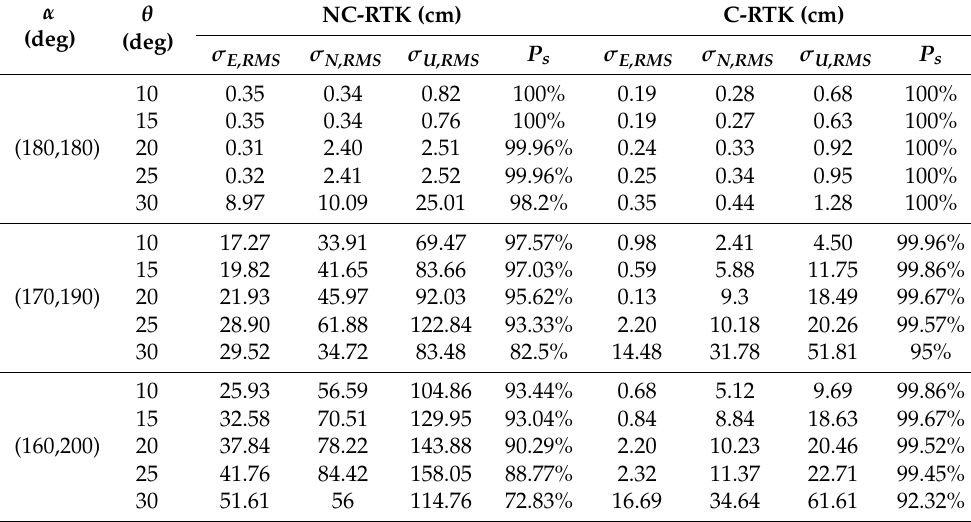
Figure 9. Positioning results with different cutoff elevation angles, in which r 1 and r 2 can track satellites whose azimuth masks are 200 ◦ and 160 ◦ . The column panels from left to right represent different cutoff elevation angles (10 ◦ , 15 ◦ , 20 ◦ , 25 ◦ , 30 ◦ ), respectively. The row panels from top to bottom are tracked satellite numbers, PDOP, ADOP (the ADOP is depicted in blue color, the 0.12-cycles level as orange dash line), and errors conditioned on PDOP<30 in east-north-up direction for the RTK positioning method using non-common clock receivers (NC-RTK) and the RTK positioning method with multiple rover receivers sharing the common clock (C-RTK), respectively. Table 5. Positioning performance and ambiguity resolution success